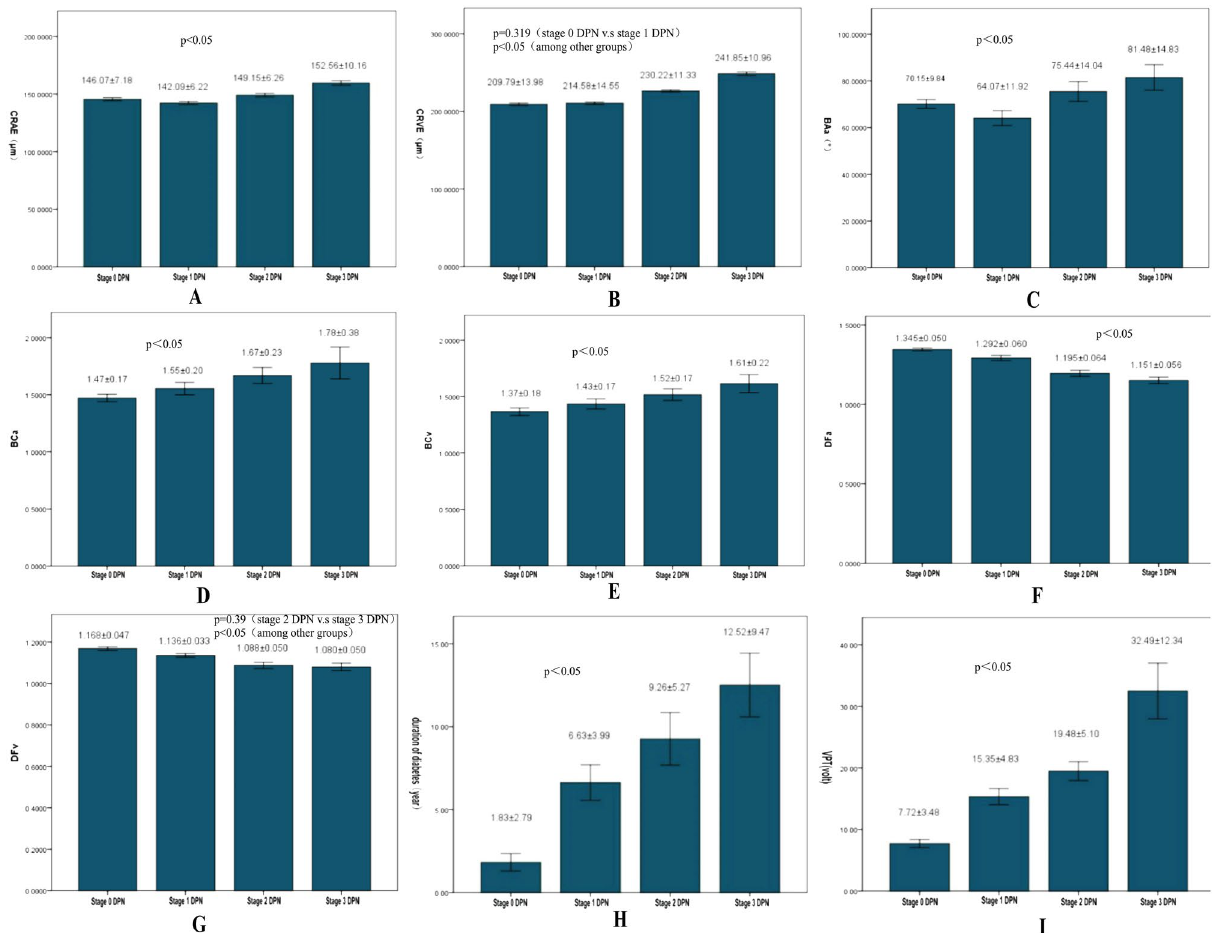
Figure 1. CRAE, CRVE, BAa, BCa, BCv, DFa, DFv, duration of diabetes, and VPT in different DPN stages. CRAE Central retinal artery equivalent, CRVE Central retinal vein equivalent, Baa Branching angle arterioles, BCa Branching coefficient arterioles, BAv Branching angle veins, BCv Branching coefficient veins, DFa Fractal dimension arterioles, DFv Fractal dimension veins, VPT Vibration perception threshold, DPN diabetic peripheral